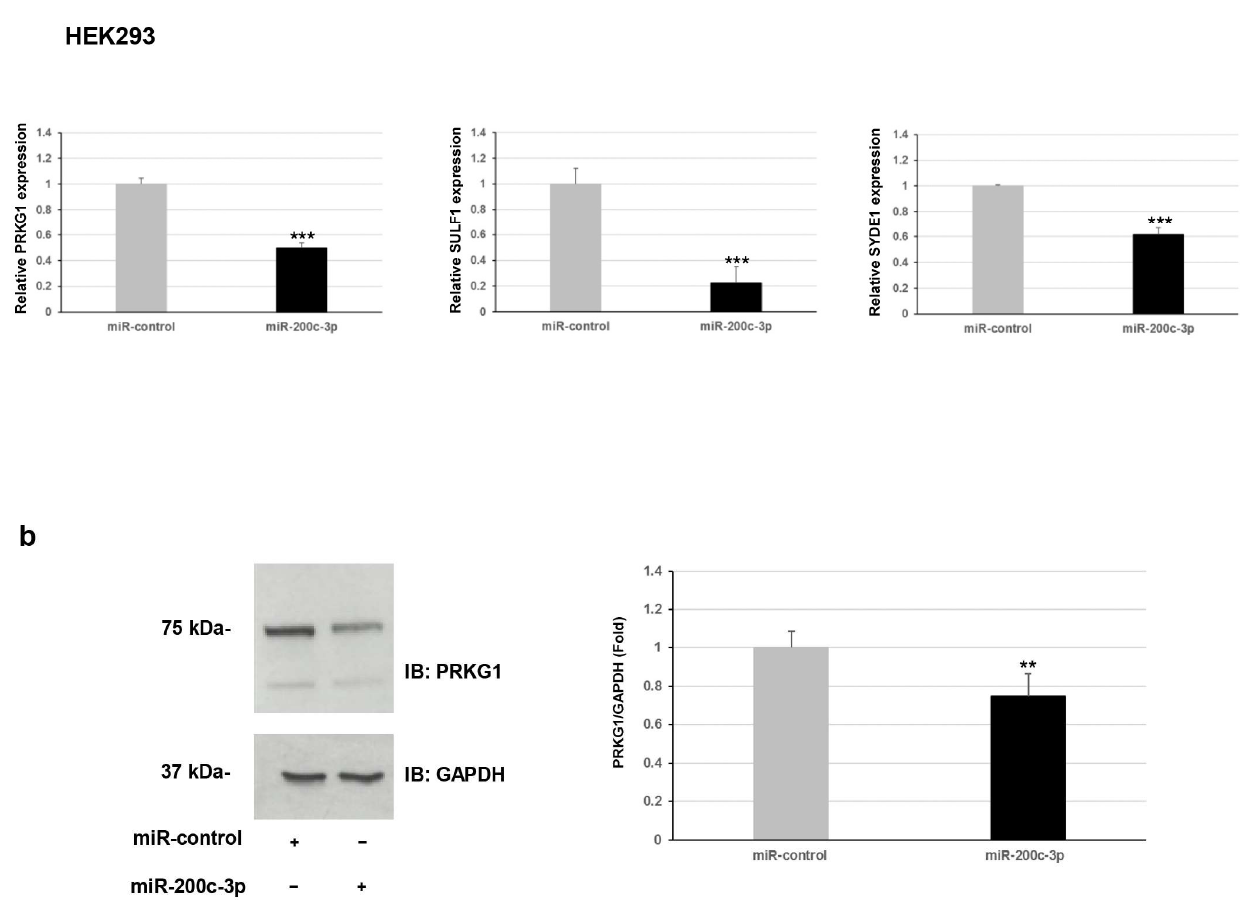
Figure 2. ( a ) Expression profile of PRKG1 , SULF1 , and SYDE1 in fibroblast (upper panel) or HEK293 cells (lower panel) transfected with hsamiR-200c-3p mimic or miR-control by quantitative PCR. Each biological replicate ( n = 3) was run in three technical replicates. Scale bars represent standard errors (** p < 0.05, *** p < 0.01). ( b ) Whole protein lysates from HEK293 transfected with hsa-miR200c-3p or miR-control were separated on 10% SDS-gel and subjected to immunoblotting with antiPRKG1 and antiGAPDH antibodies. Levels of PRKG1 and GAPDH were quantified by densitometry using IMAGEJ analysis software. Relative PRKG1 level was normalized compared to GAPDH level. Scale bars represent standard errors (*** p < 0.01, biological replicates = 3). Whole protein lysates from HEK293 transfected with.